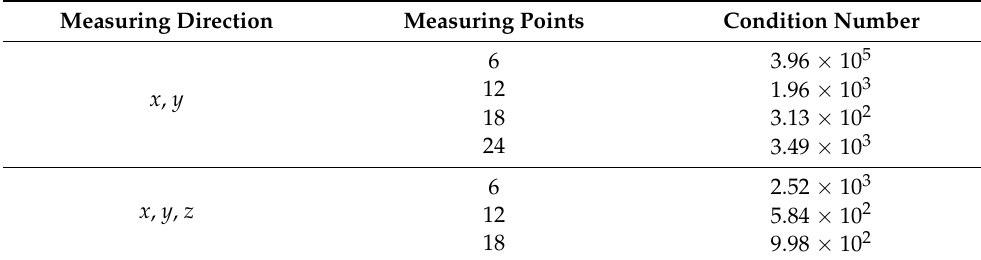
Table 6. Condition number of relative sensitivity matrix for